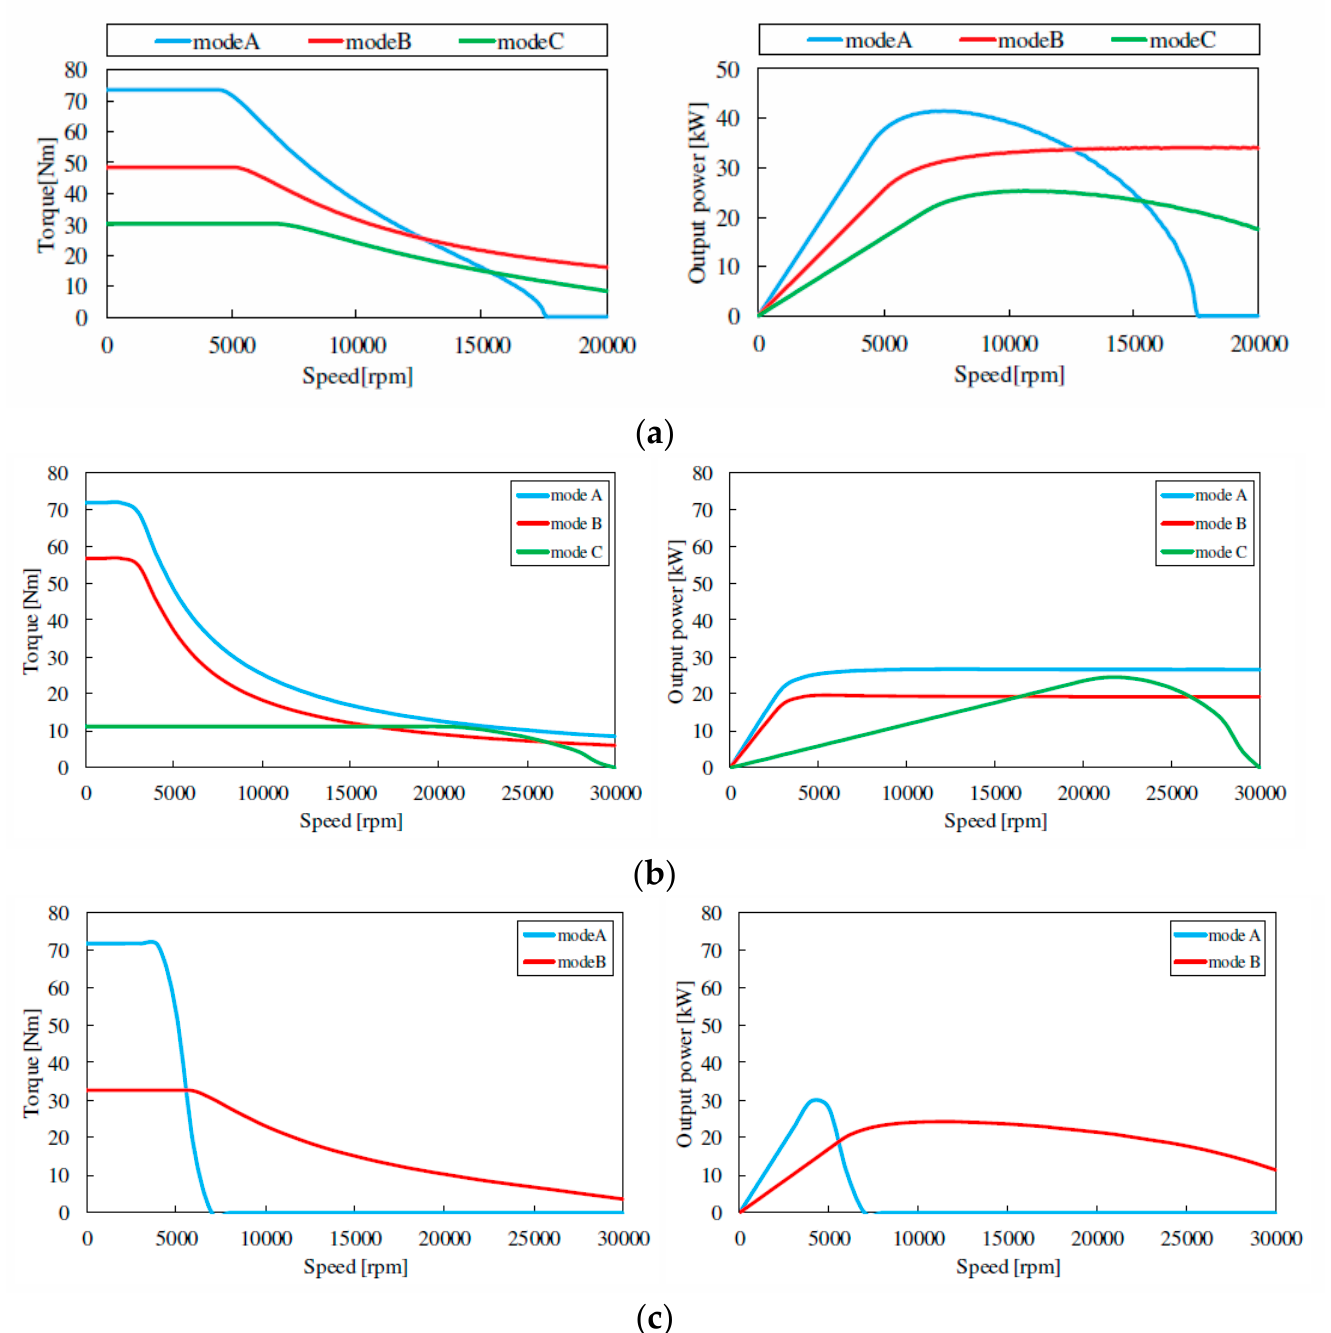
Figure 7. ( a ) Output characteristics of the proposed 3 mode motor. (Left) Torque-Speed curve, (Right) Output power-Speed curve. ( b ) Output characteristics of the 25 turn-3 turn motor. (Left) Torque-Speed curve, (Right) Output power-Speed curve. ( c ) Output characteristics of the 14 turn-14 turn motor. (Left) Torque-Speed curve, (Right) Output power-Speed curve.